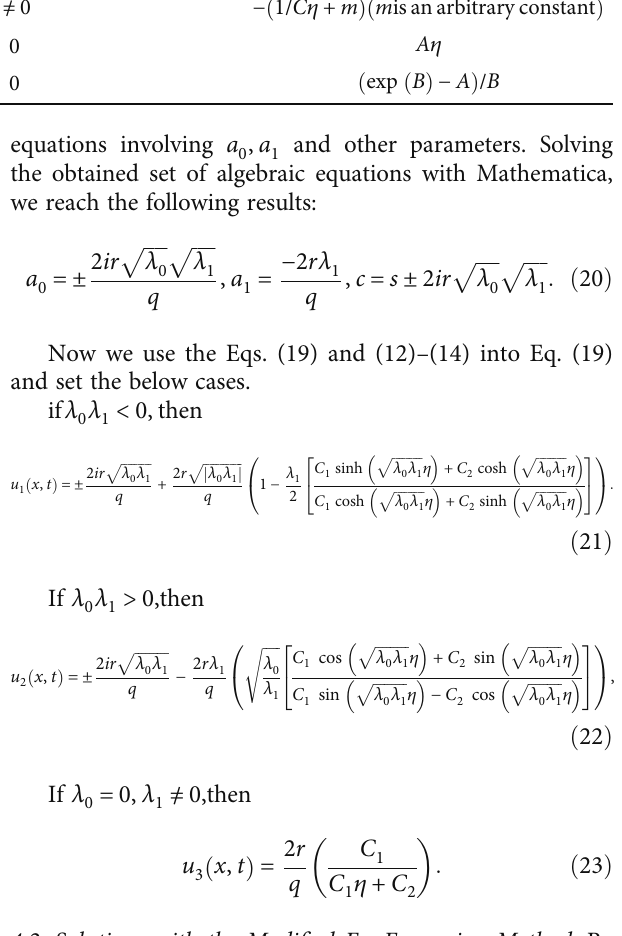
Figure 1: 2D and 3D graphics for hyperbolic traveling wave solution (21) at f β = 0 : 5, r = 1, q = 1, λ 0 = 0 : 5, λ 1 = 0 : 5, C 1 = 1, C 2 = 0, c = 1 g